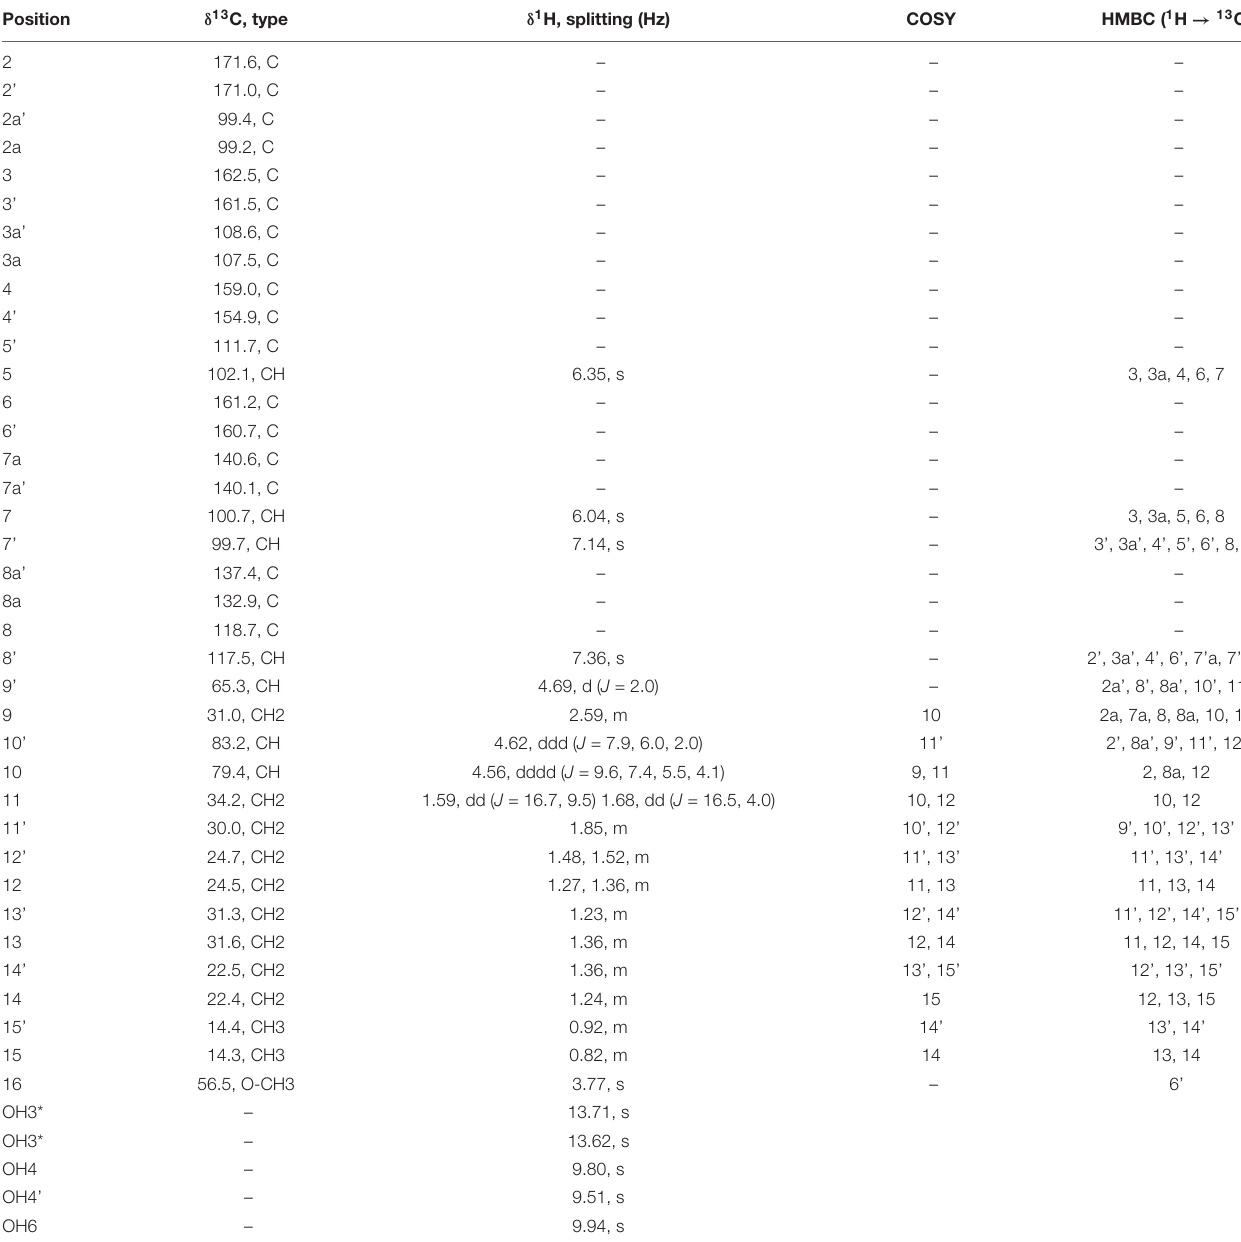
TABLE 1 | Summary of chemical shift and correlations for 2 (DMSO- d 6